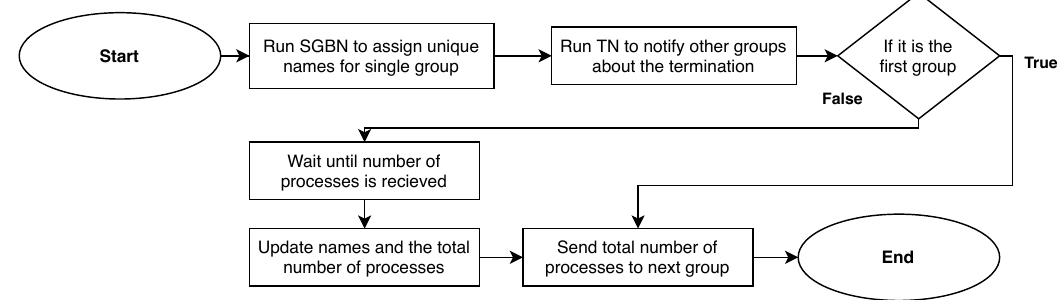
Figure 2. Flow chart of the two parts in the MCBN algorithm.